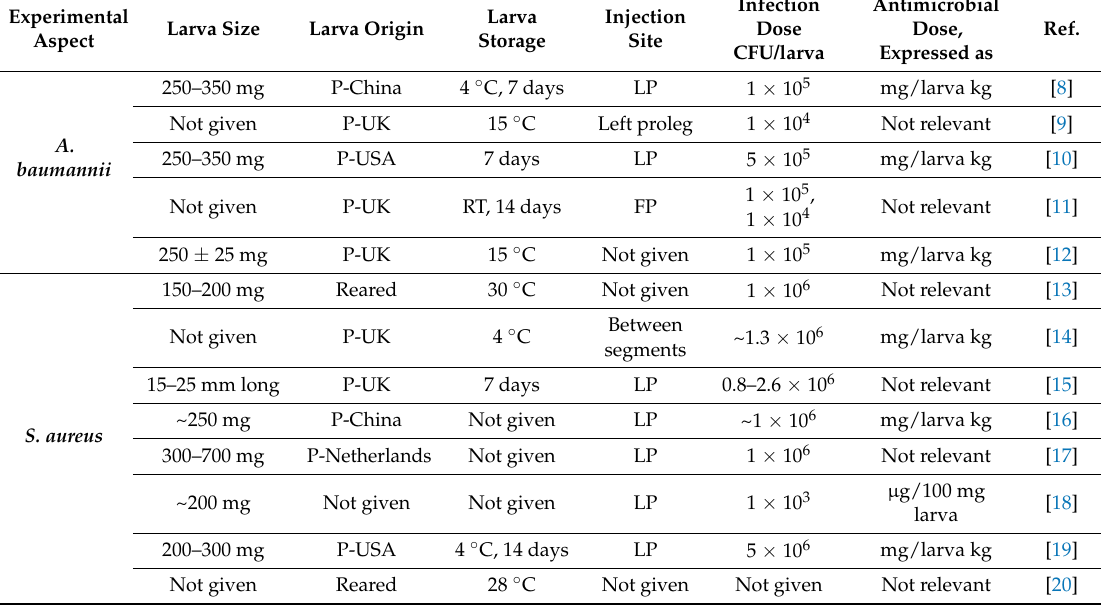
Table 1. Comparison of experimental aspects of the G. mellonella model infection protocol, as performed in different laboratories, for two bacterial pathogens ( Acinetobacter baumannii , Staphylococcus aureus ). Experimental